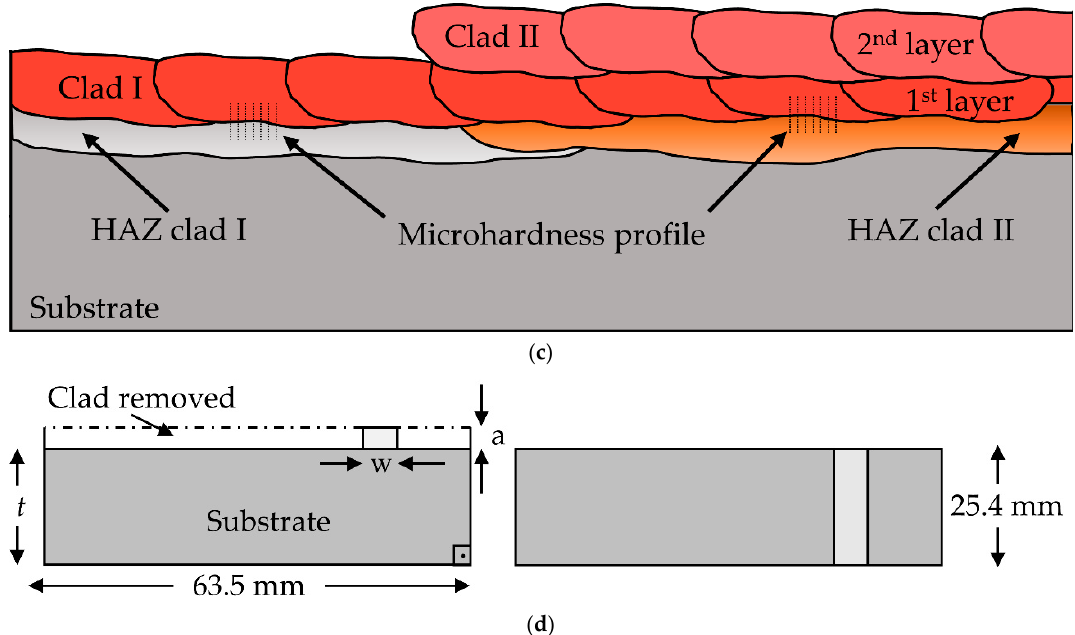
Figure 1. Schematic representation of 9%Ni steel (ASTM A333 Gr. 8) pipes cladded with one and two layers of Ni-based superalloy 625 (AWS ER NiMoCr-3) ( a ); microstructure of the pipes observed in the as received state (quenched and tempered) ( b ); locations of Vickers microhardness (HV0.01) measurements ( c ); shear test specimen, where a = 3.1 mm (clad I) and 4.7 mm (clad II), t = 25.4 mm, according to ASTM A265-12 ( d ). Table 1. Specified and analyzed chemical compositions of the base and filler metals, and the analyzed chemical compositions of clad I and the second layer of clad II.